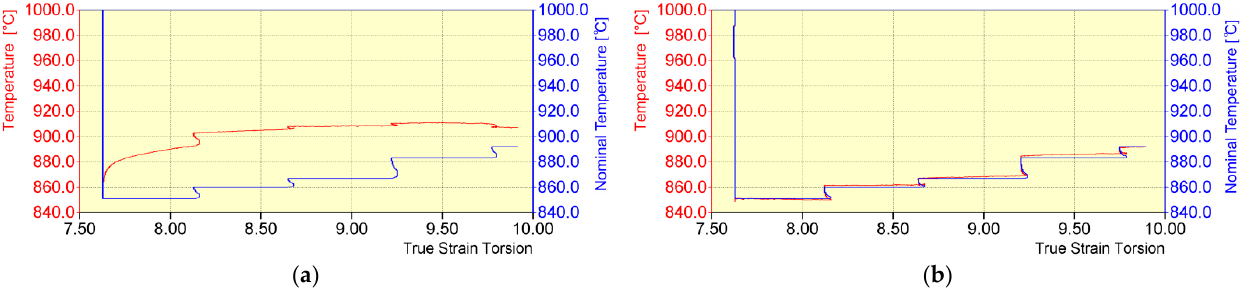
Figure 8. Example temperature distribution (nominal and obtained) during the initial stage of the deformation process in an NTM block: ( a ) accelerated cooling time before the NTM block (8.5 s) and ( b ) accelerated cooling time before the NTM block (55 s: accelerated cooling for 40 s and holding for 15 s).